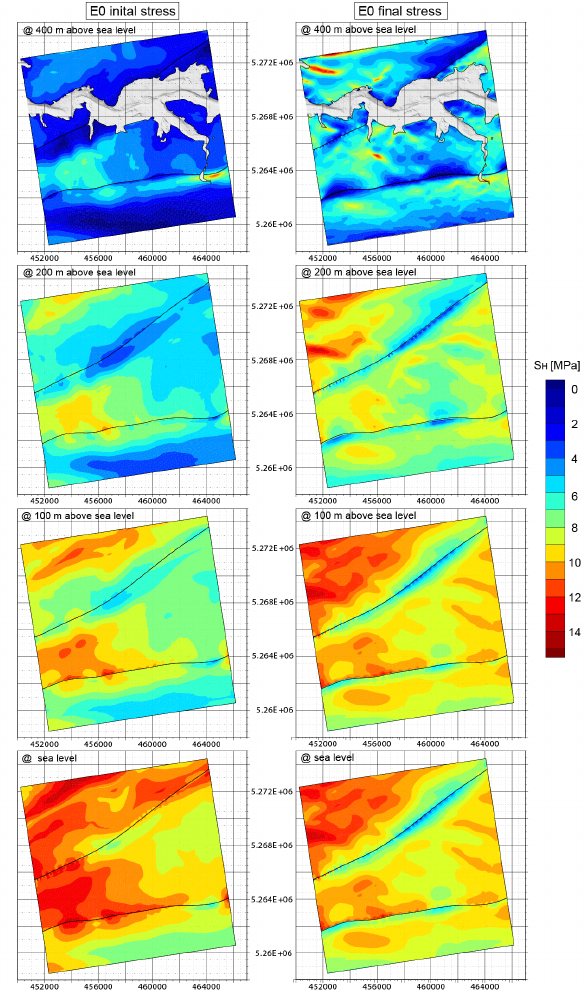
Figure 13. S H magnitude from the homogeneous model (E0) at different elevations with respect to sea level. Left column without displacement boundary conditions, right column with displacement boundary conditions